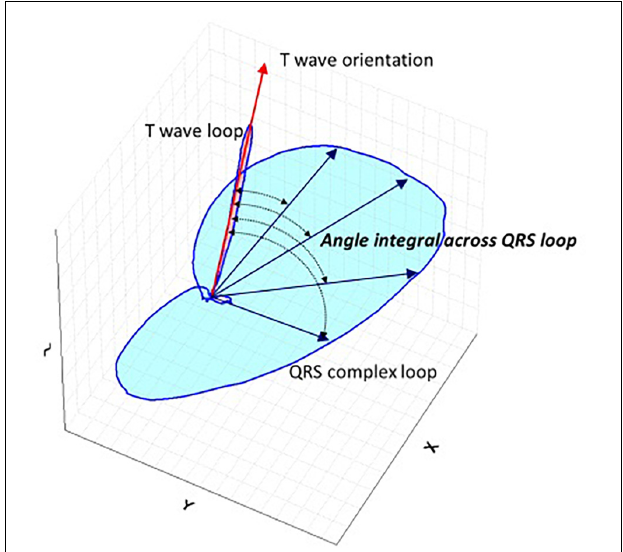
FIGURE 1 | Schematic representation QRS-T angle. Schematic spatial representation of QRS and T vector loops. Main vector of T wave loop is depicted by red arrow and main vectors of QRS loop are depicted with blue straight arrows. Total Cosine R to T is the average of cosines of the angles between the three-dimensional T wave and QRS loop vectors and measures the vectorial deviation between depolarization and repolarization waves. For the three-dimensional reconstruction of the cardiac electrical signal from the surface 12 lead digital ECG, the eight independent leads are subjected to singular value decomposition to yield a system of 3 independent orthogonal leads that contain 99% of the ECG